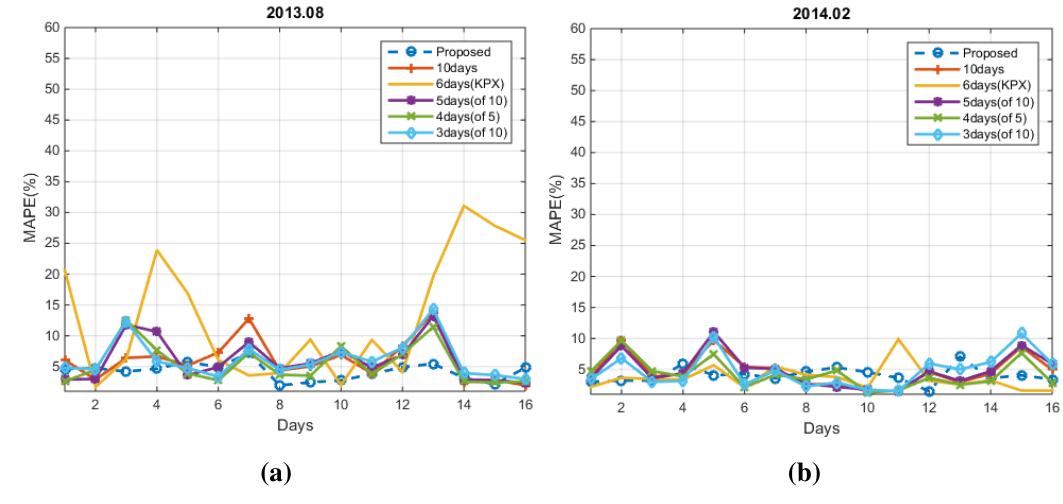
Figure 13. MAPE evaluation of site C in summer season ( a ) and winter season ( b